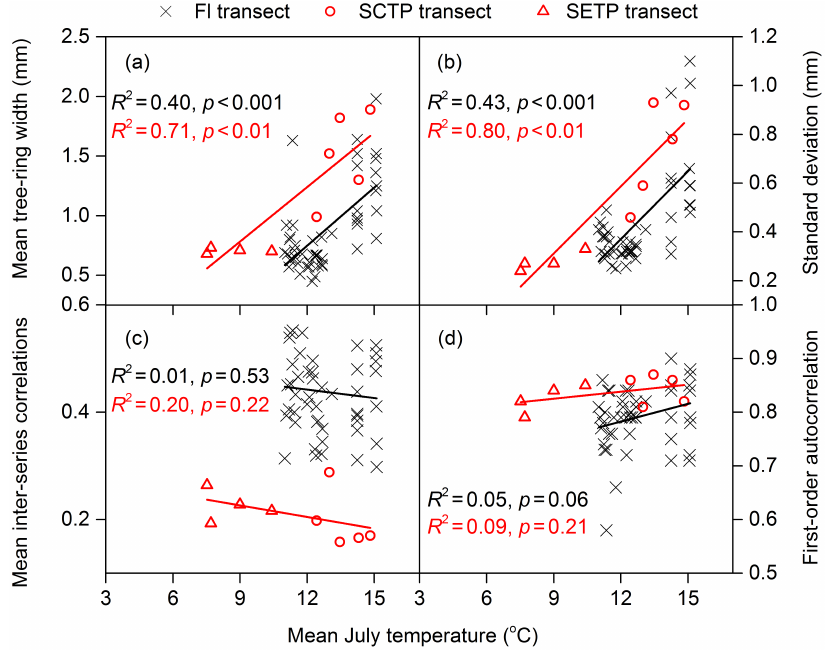
Figure 3. Stand level statistics of raw tree-ring widths along the latitudinal gradient in Finland (FI) and the altitudinal gradients on the Tibetan Plateau (TP). The lines are linear regression lines. The black colour marks the data for the latitudinal gradient, and the red denotes the data for the altitudinal